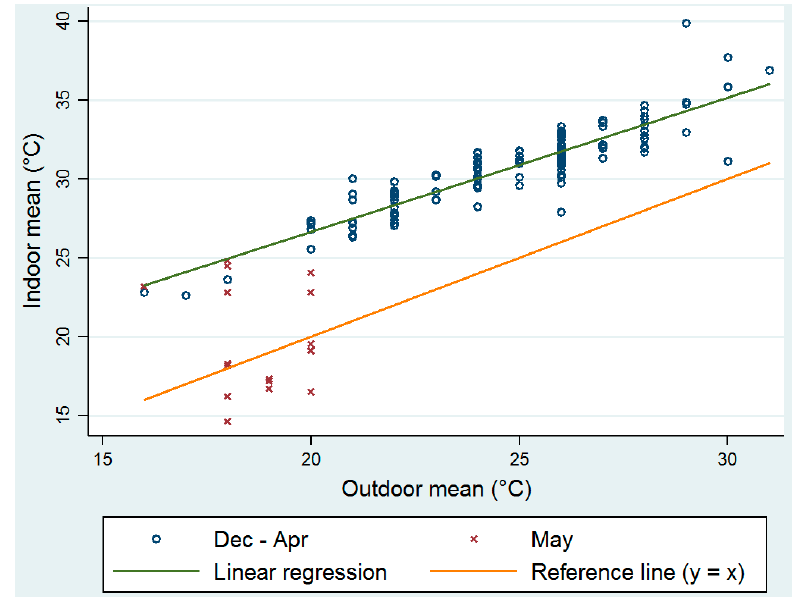
Figure 4. Linear regression for the period December to April between daily mean indoor apparent temperature and outdoor temperature (intercept β 0 = 9.6, se( β 0 ) = 0.88, slope β 1 = 0.9, se( β 1 ) = 0.04, model R 2 = 0.811).